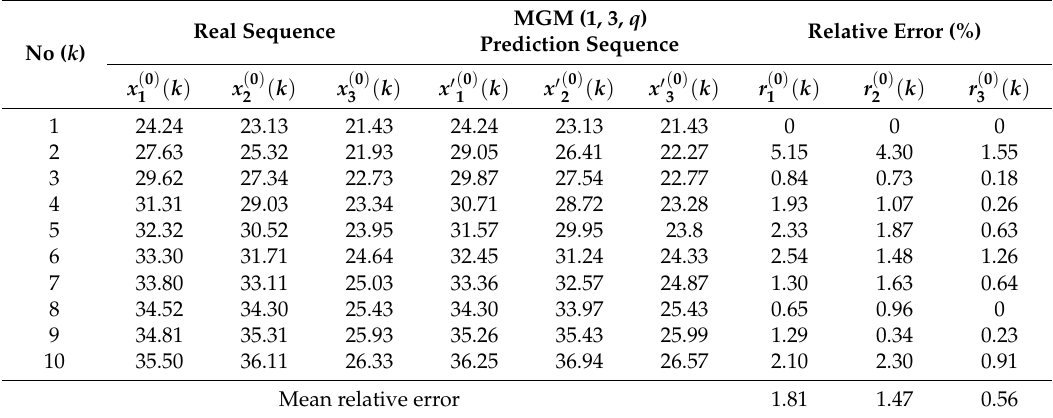
Table 3. GM (1, 1) model fitting value and error analysis.